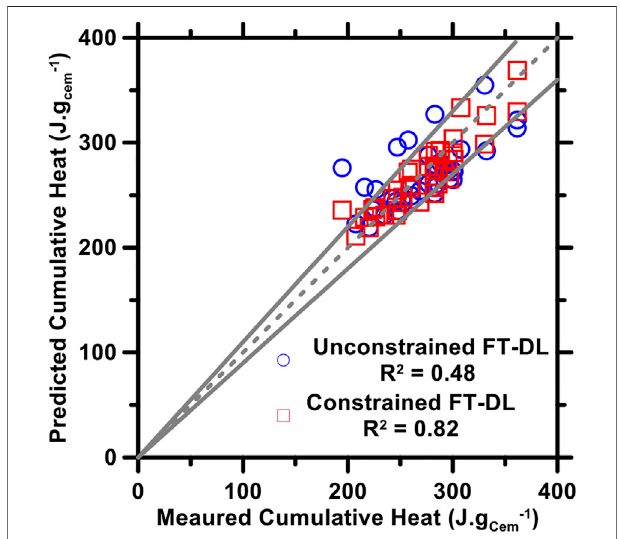
FIGURE 7 | Predictions of cumulative heat at 24 h produced by the FT- DL model – with and without thermodynamic constraint – compared against experimental measurements. The coef fi cients of determination ( R 2 ) of the predictions are shown in the legends. The dashed and solid lines represent the line of ideality and ± 10% error bounds, respectively.